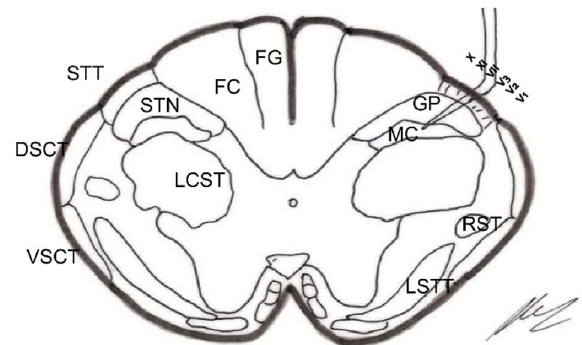
Figure 10. Section of the trigeminal spinal tract (TST) at the level approximately 11 mm below the obex (modified from [122]). GN—Gracile Nucleus. CN—Cuneate Nucleus. STrigT—Spinal Trigem- inal Tract. STrigN—Spinal Trigeminal Nucleus. AECT—Anterior Spinocerebellar Tract. PECT— Posterior Spinocerebellar Tract. ATLS—Anterolateral System. CG—Central Gray.